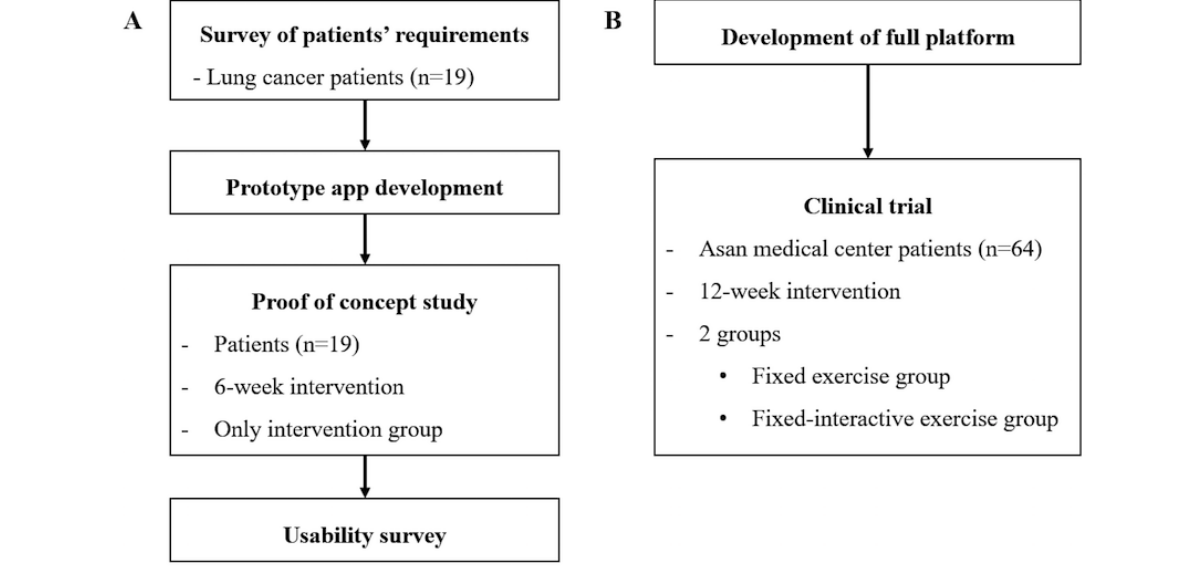
Figure 1. Study design. (A) Flow of the proof-of-concept study; (B) flow of the clinical